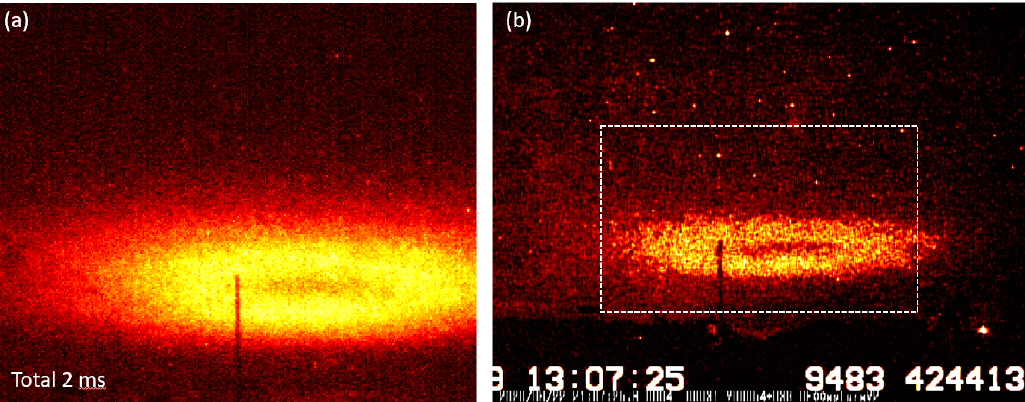
Figure 6. ( a ) An elve image recorded by the low-light-level CCD system at time 13:07:25.9316 on 22 June 2020 while simultaneously ( b ) the time-integrated images of 20 image frames recorded by the intensified high-speed camera system with exposure time 100 us.